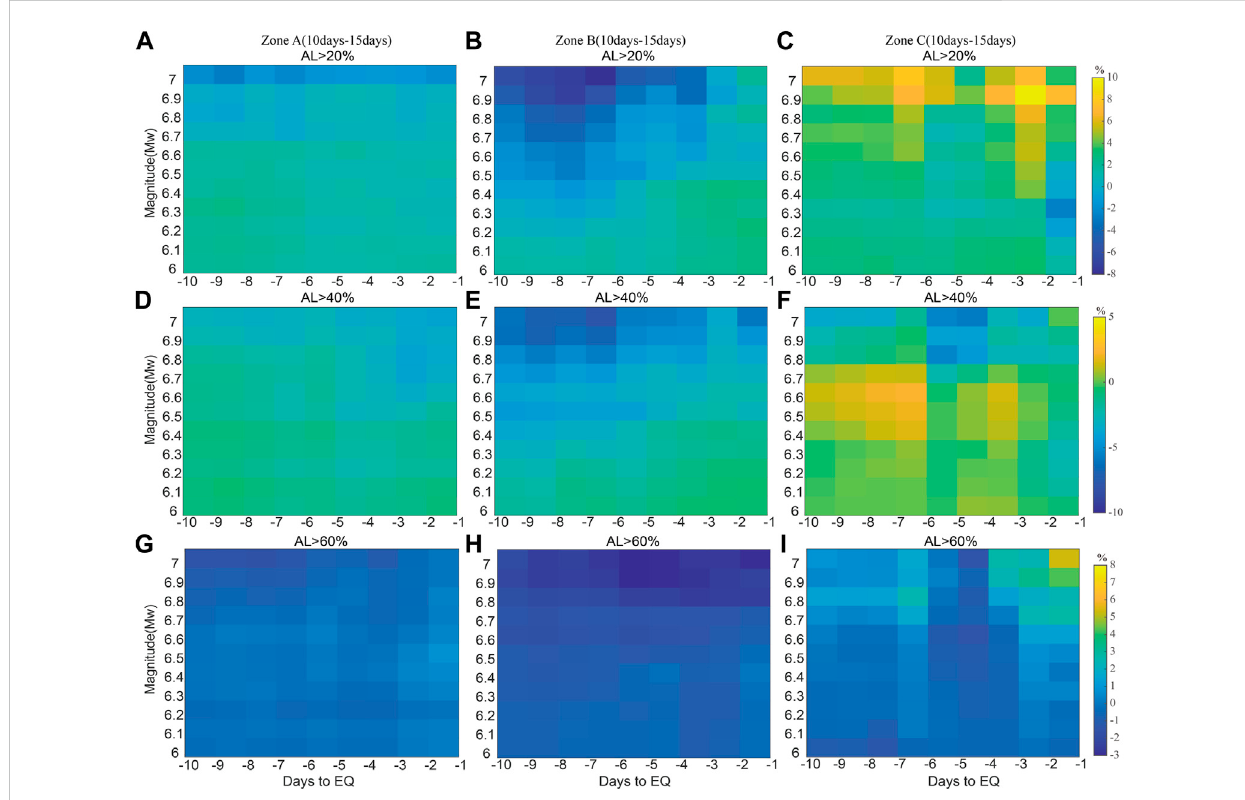
FIGURE 8 The differences of seismo-ionospheric anomalies occurrence rates between the results of 10-day and 15-day sliding windows. (A, D, G) represent the results in Zone A. (B, E, H) represent the results in Zone B. (C, F, I) represent the results in Zone